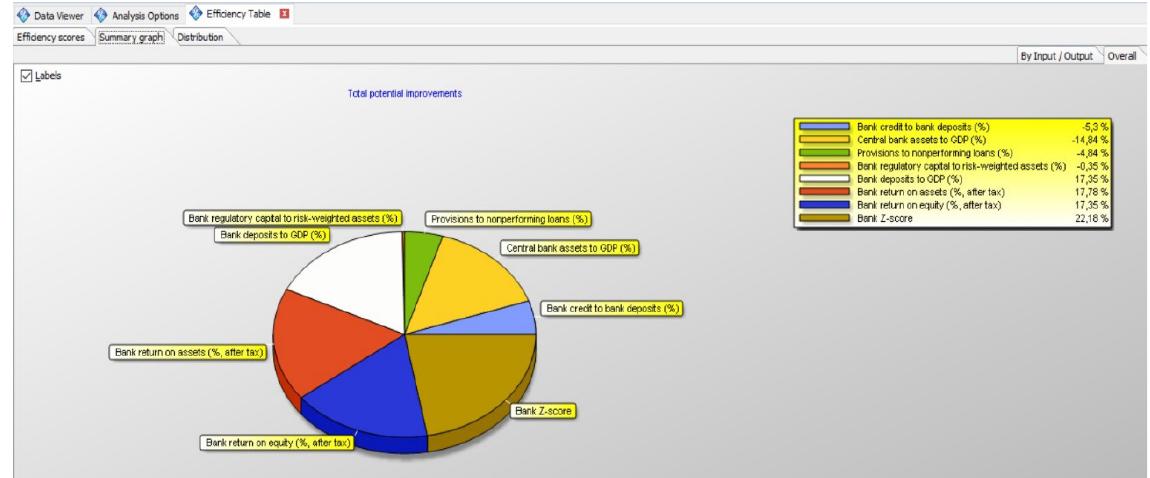
Figure 9. Potential for improving the efficiency of banking systems in 17 European countries and Ukraine as of 2020 for the DEA CCA